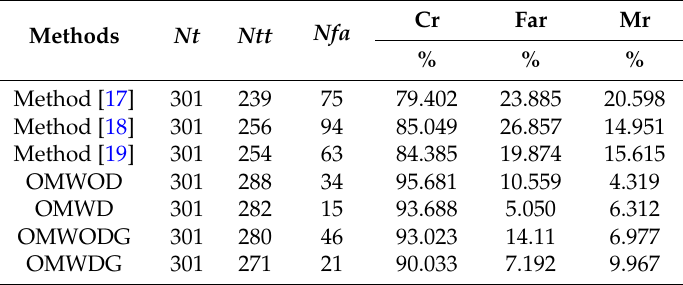
Table 3. Comparison of the results of different